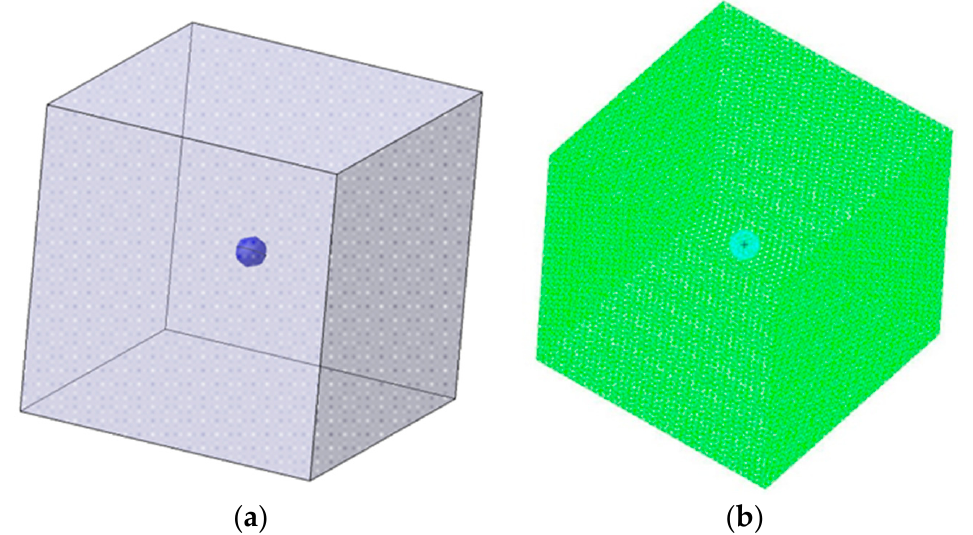
Figure 15. Illustration of the ( a ) cube-cell element and ( b ) finite element model with an embedded microcapsule.